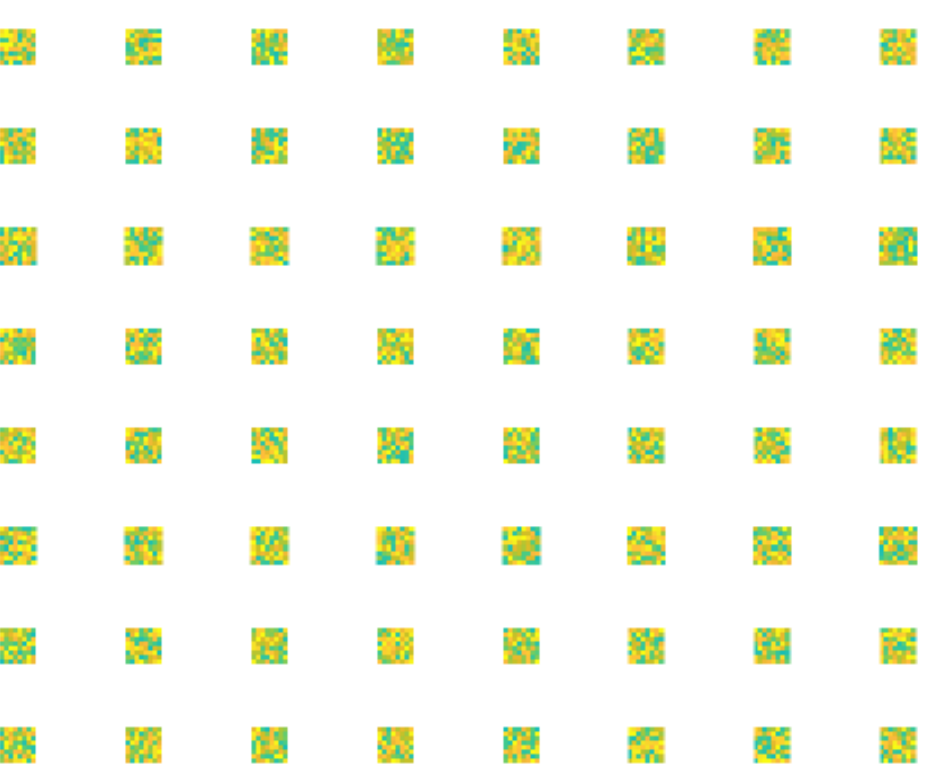
Figure 3. Bases obtained when running the algorithm for iterations and choosing 64 bases Sparse with 64 × 64 pixels.